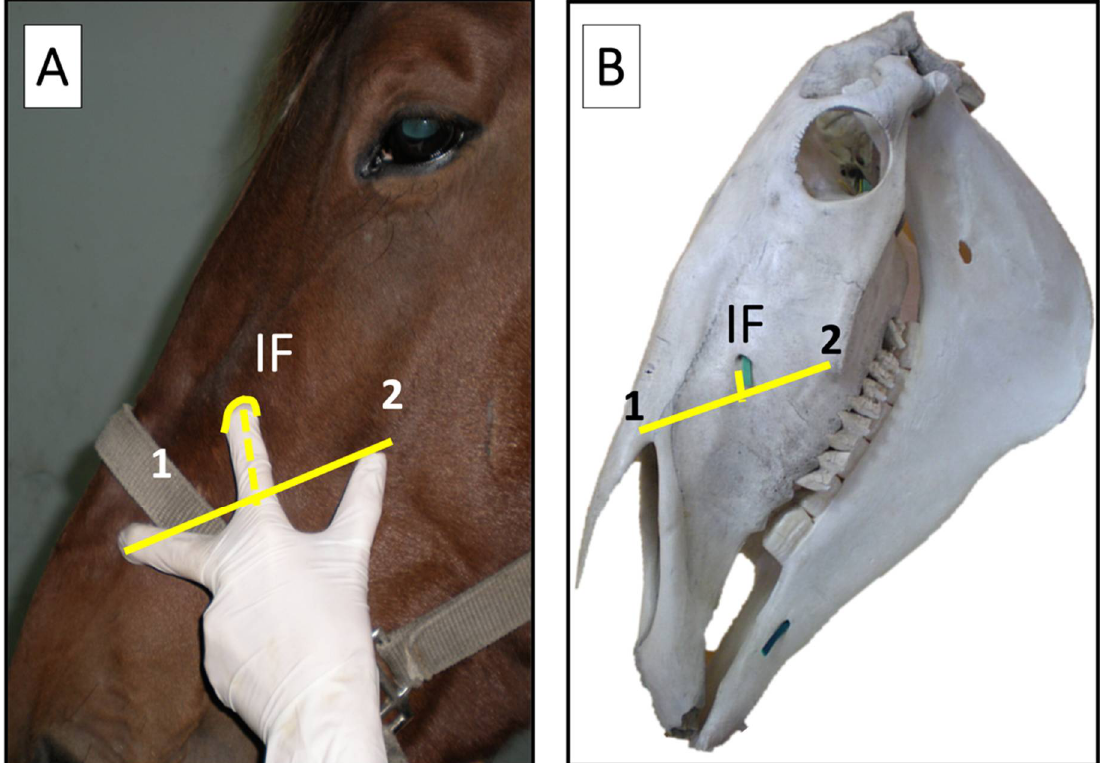
Figure 1. The ‘three fingers grip’ technique in vivo ( A ) and anatomical landmarks in a skull ( B ) used to localize the infraorbital foramen (IF), which lies below the levator labii superioris muscle . 1: naso-incisive notch; 2: facial crest.